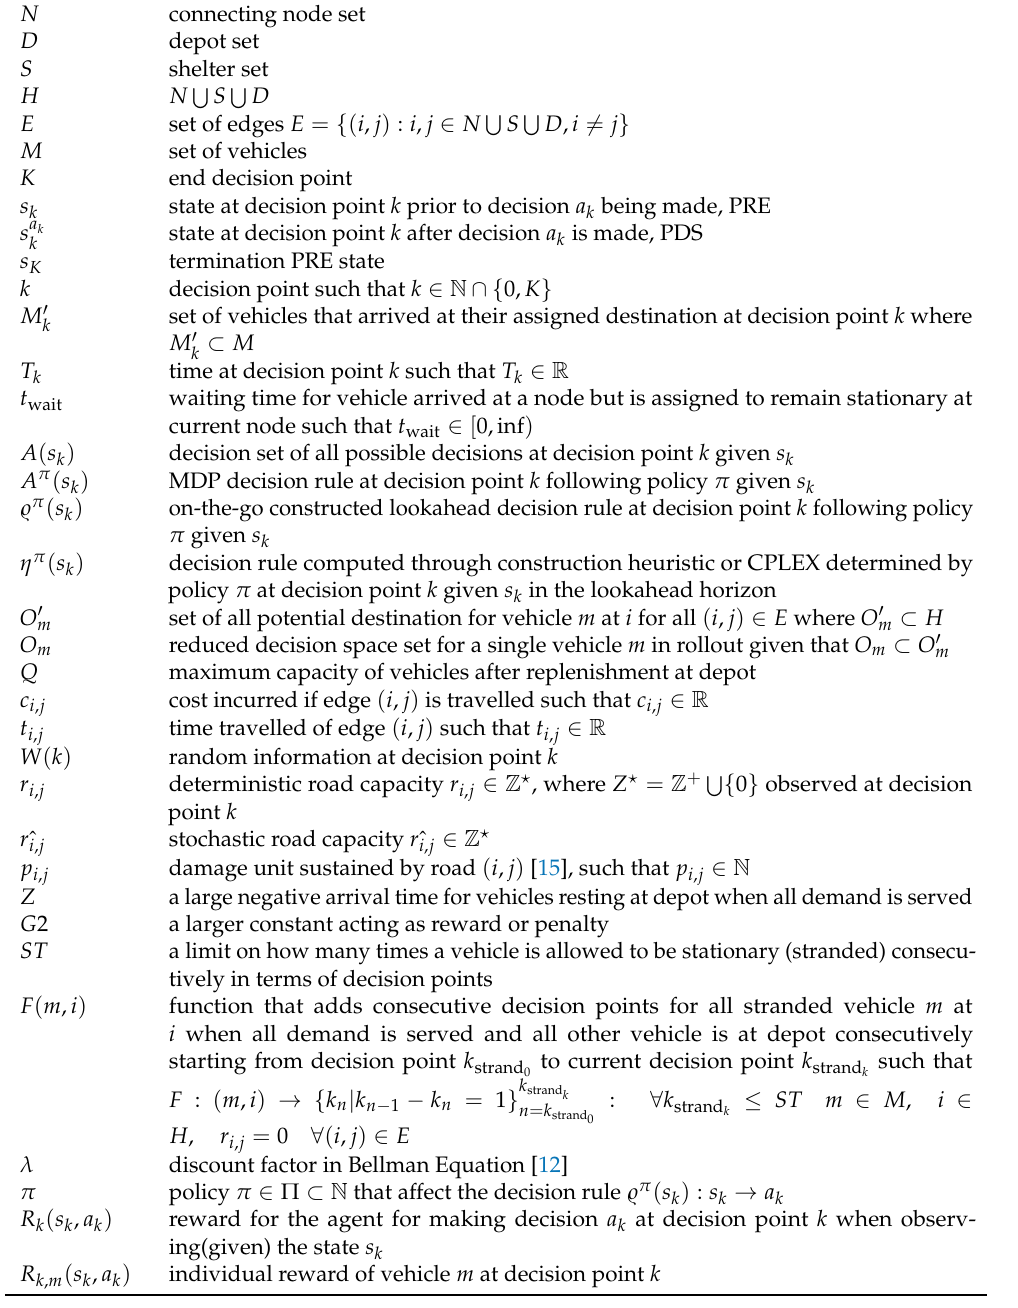
Table 1. MDDVRPSRC: